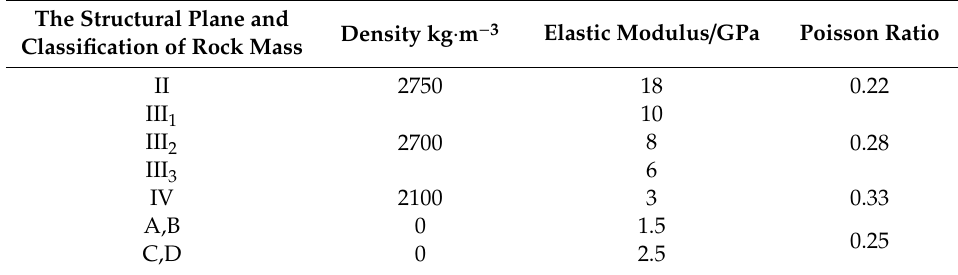
Table 2. Performance parameters of foundation